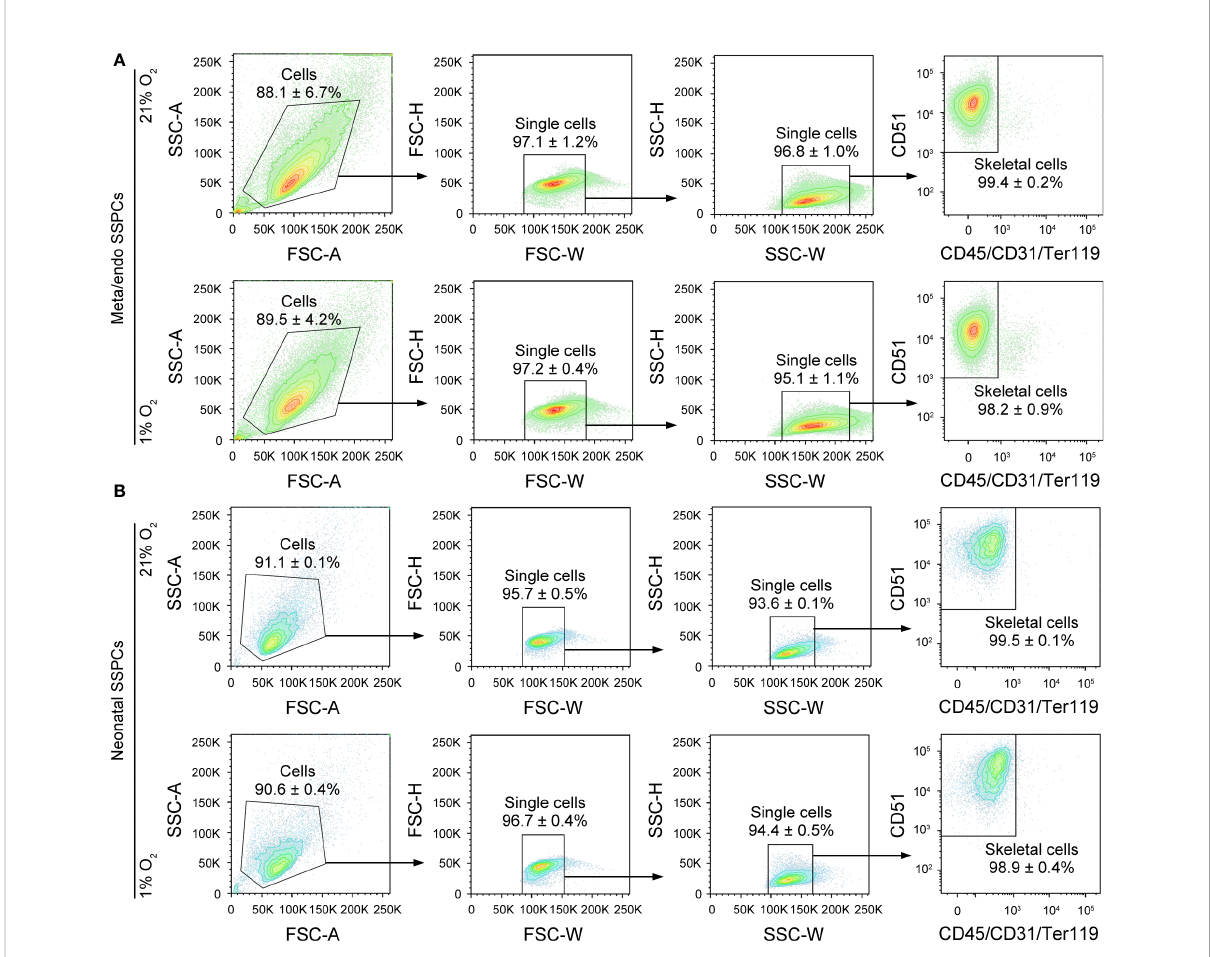
FIGURE 5 Flow cytometry-based validation of depleting the contaminating CD45 + /CD31 + /Ter119 + cell population in cultured metaphyseal/endosteal and neonatal cells. (A) Contour plots showing the gating strategy used for fl ow cytometry-based quanti fi cation of the percentage of skeletal cells (CD51 + CD45 - CD31 - Ter119 - ) after depletion of CD45 - CD31 - Ter119 - and expansion of puri fi ed metaphyseal/endosteal SSPCs in 21% O 2 (upper panels) and in 1% O 2 (lower panels) (n=3). (B) Contour plots showing the gating strategy used for fl ow cytometry-based quanti fi cation of the percentage of skeletal cells (CD51 + CD45 - CD31 - Ter119 - ) after depletion of CD45 - CD31 - Ter119 - and expansion of neonatal SSPCs in 21% O 2 (upper panels) and in 1% O 2 (lower panels) (n=3). Data are shown as mean ±